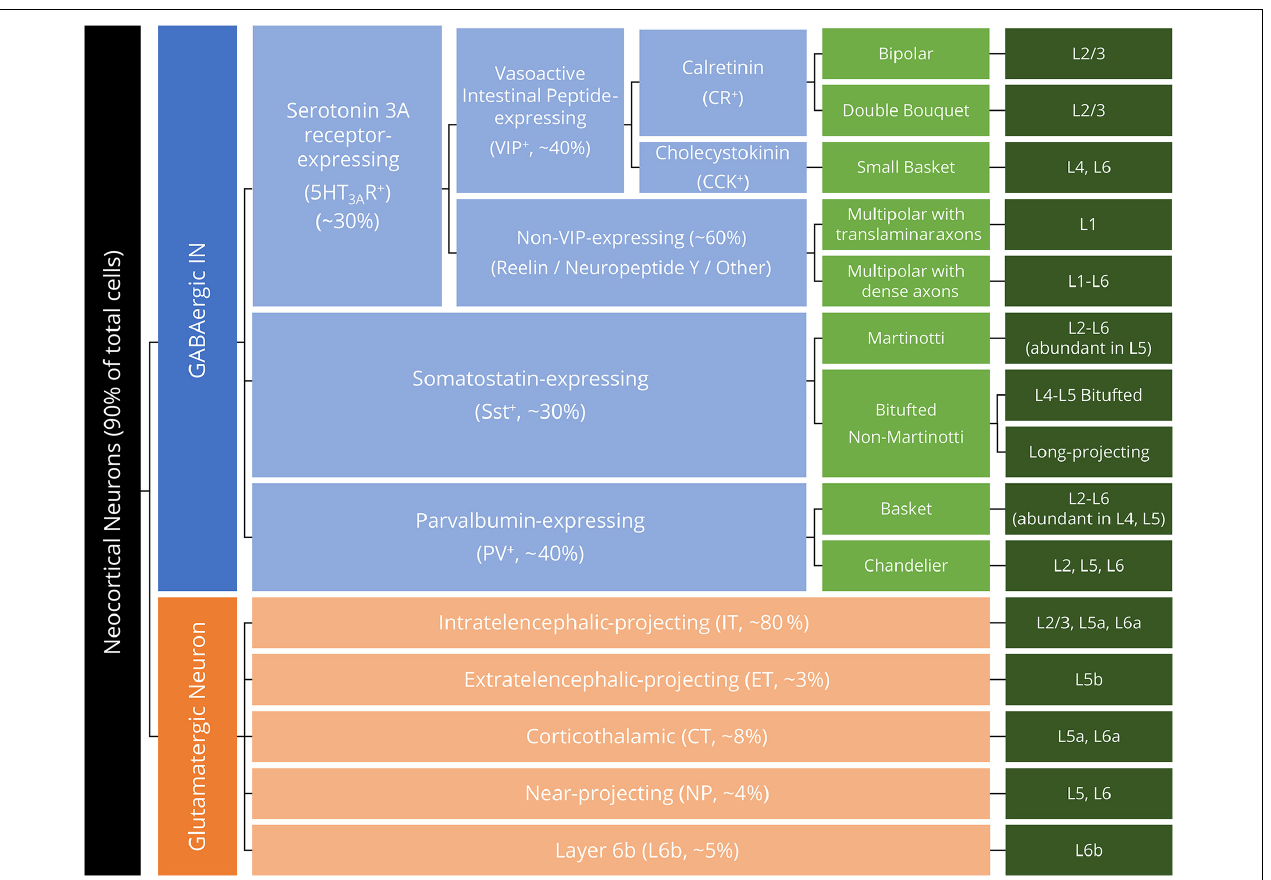
FIGURE 1 | Hierarchical neuron taxonomy of the human motor cortex. All neurons are classified by the neurotransmitter glutamate and GABA as glutamatergic (excitatory) neurons (orange boxes) and GABAergic interneurons (INs, blue boxes). For the morphologically diversified INs, the morphological feature of the IN is specified in light green boxes. Dark green boxes denote the laminar distribution (layer, L) of the listed neuron